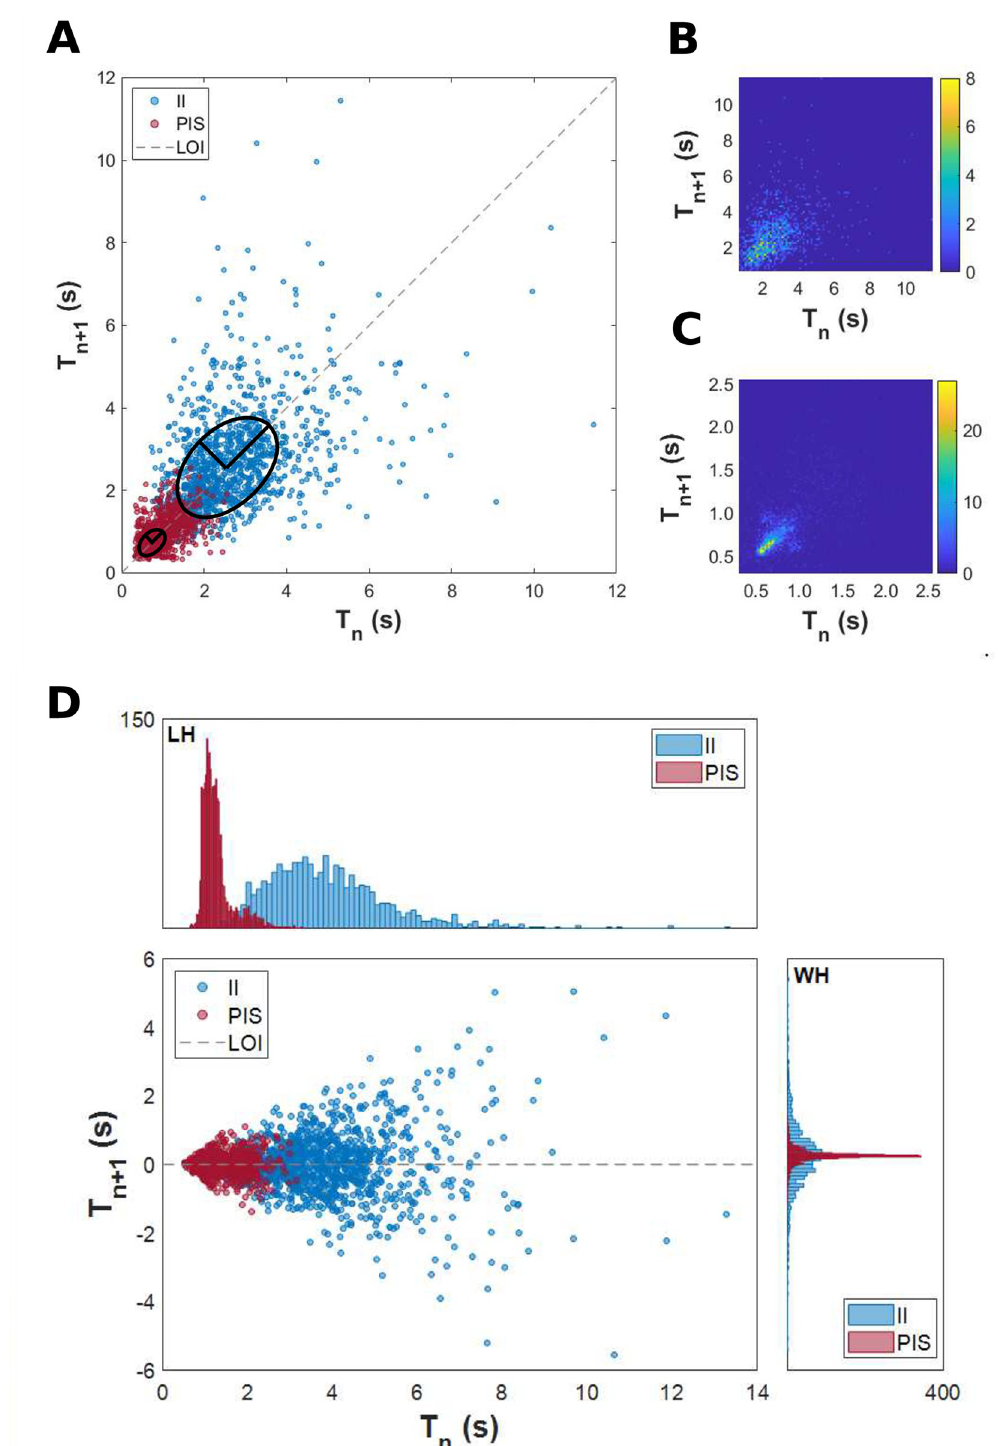
Fig 4. Spread pattern of interspike intervals. (A) Poincare´ map from all interspike intervals. The II activity presents a higher variability of spread of its interspike intervals than the PIS pattern, with SD1II = 0.94 and SD2II = 1.48. The values of the minor axis and the major axis of the fitted ellipse for the PIS pattern are SD1PIS = 0.18 and SD2PIS = 0.35, respectively. Bivariate histogram of interspike intervals from (B) interictal-like events and (C) periodic ictal spiking. The color bar indicates the amplitude for each 100 bins. (D) “Length histogram” (superior panel) and “width histogram” (right panel) from Poincare´ map points projected onto the line of identity and orthogonal to the line of identity, respectively. All histograms are defined with 100